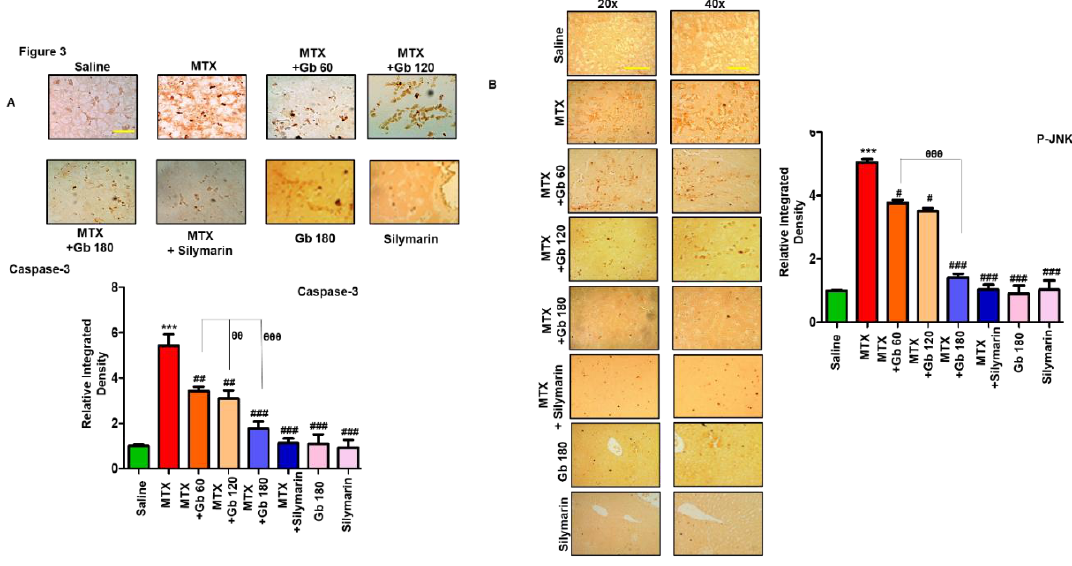
Figure 3. Gb attenuated apoptotic markers. The presented images indicate the immunoreactivity of ( A ) caspase-3 and ( B ) p-JNK. Scale bars = 50 μm (20× magnification) and 20 μm (40× magnification); n = 5 per group. Data presented are relative to saline, and the number of experiments performed was three. Data are presented as means ± SEM and were analyzed by one-way ANOVA followed by Bonferroni multiple comparison post hoc testing. The symbol ∗ shows a significant difference relative to saline, while # shows a significant difference relative to the MTX group. The symbols ∗∗∗ or ### or θθθ represent p < 0.001, while ## or θθ represent p < 0.01, while # shows p < 0.05.